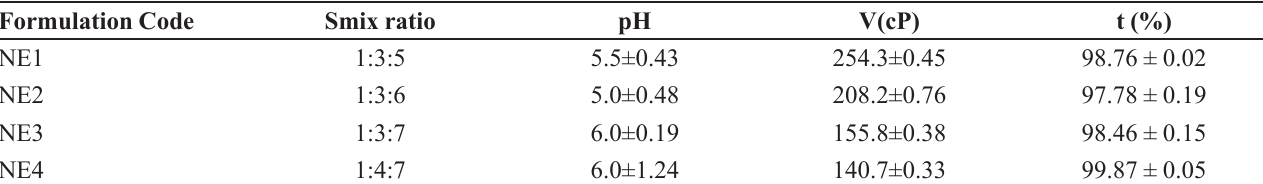
TABLE IV - Determination of pH, viscosity and transmittance of various nanoemulsion formulations Formulation